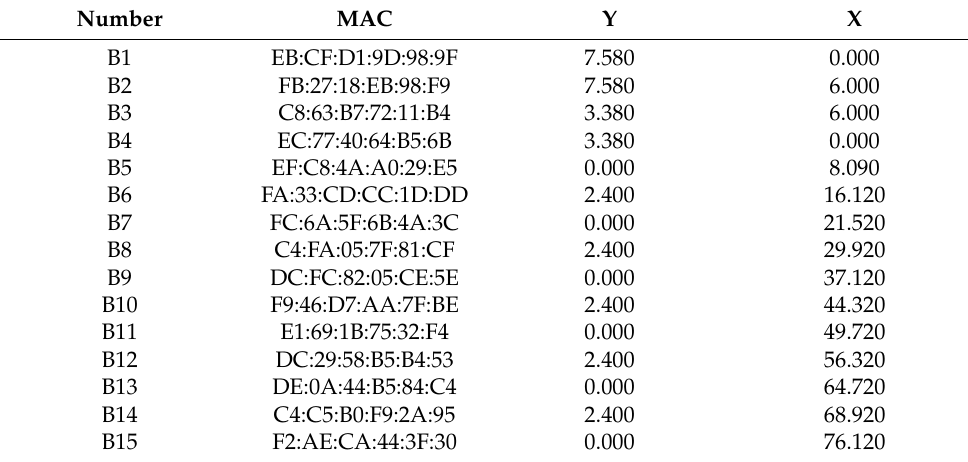
Table 3. iBeacons’ MAC and